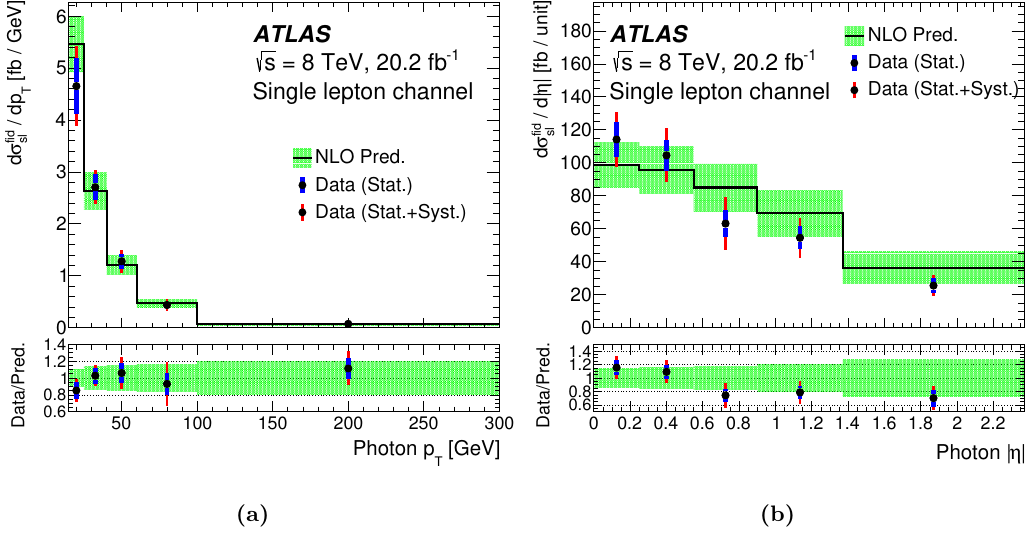
Figure 4. Measured di(cid:11)erential cross section in (a) p T and (b) j (cid:17) j and the corresponding theoretical